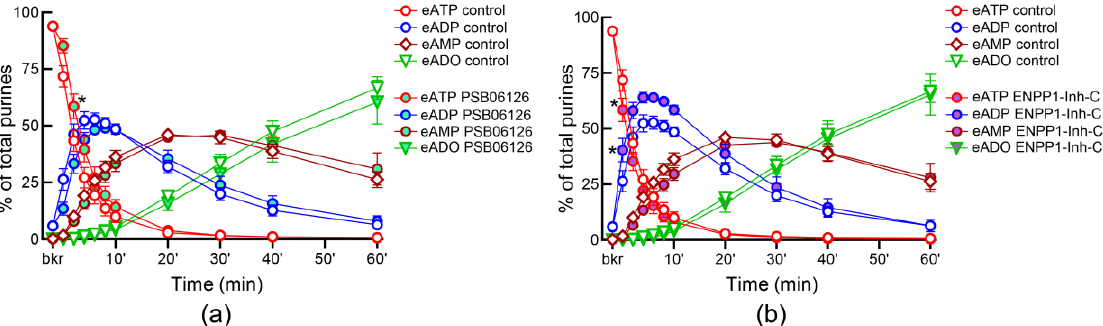
Figure 3. Effects of PSB06126 and ENPP1-Inhibitor-C on the hydrolysis of eATP by soluble en- zymes released in bladder lumen during filling. Changes in eATP, eADP, eAMP, and eADO in ILS in the presence of vehicle (DMSO 0.1%, n = 7) or PSB06126 (10 µM, n = 3) ( a ) or ENPP-Inh-C (50 µM, n = 4) ( b ); n , number of bladder preparations. eATP, eADP, eAMP and eADO are presented as percentages of total purines (eATP + eADP + eAMP + eADO) present in reaction solutions. * p < 0.05 vs. control, 2 way ANOVA with Sidak’s multiple comparisons test.